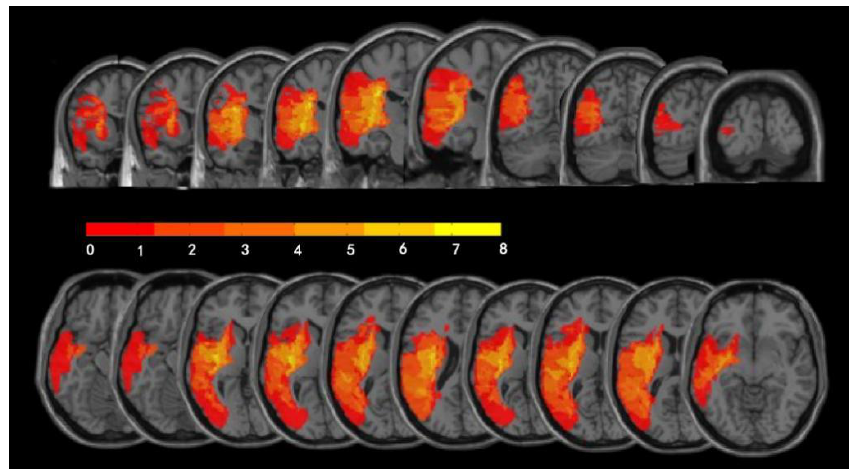
Figure 2. Lesion overlap map across 16 patients with PSA illustrating the distribution of lesions. The color scale in the spectrograms represents the injured brain locations’ magnitude of a frequency.